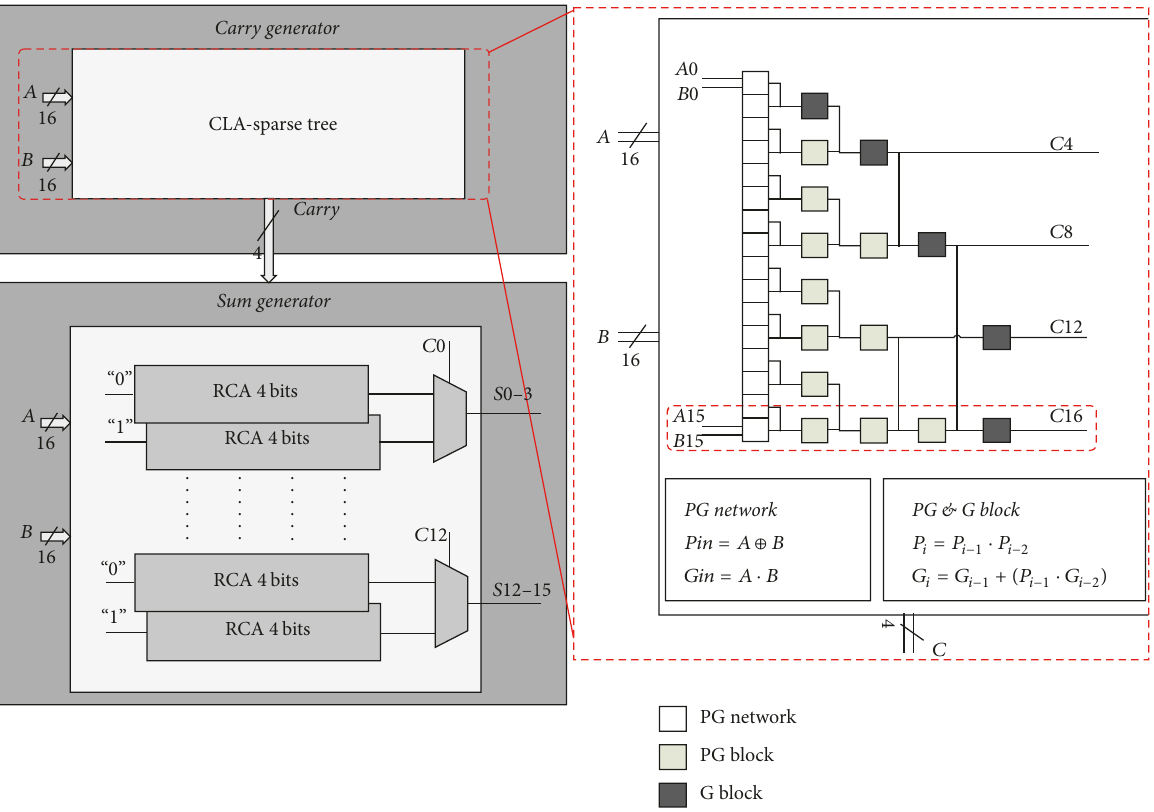
Figure 16: The general block diagram of the P4 adder and the carry generator block of P4 adder consists of a sparse tree.